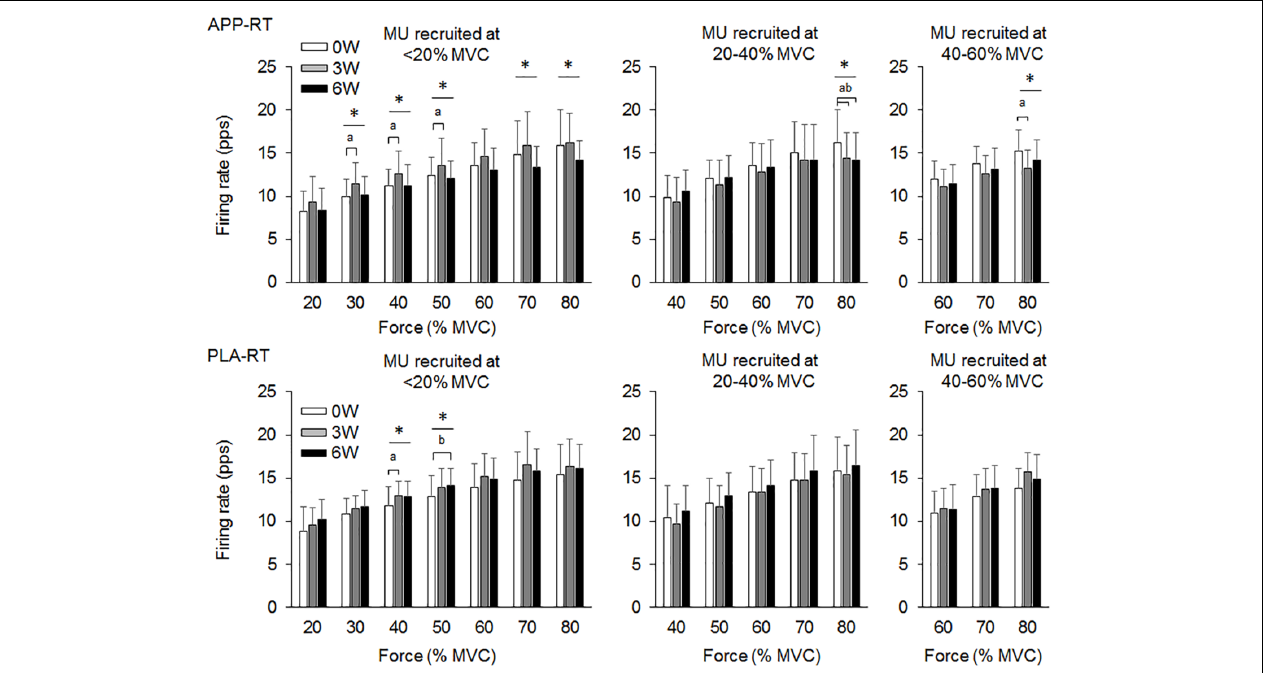
FIGURE 3 | Motor unit firing rates of the group with fish protein intake and resistance training (APP-RT) and the group with placebo and resistance training (PLA-RT). MU, motor units. The symbols ∗ , a , and b indicate significant differences ( p < 0.05) among the periods, between 0 and 3 weeks, and between 0 and 6 weeks,